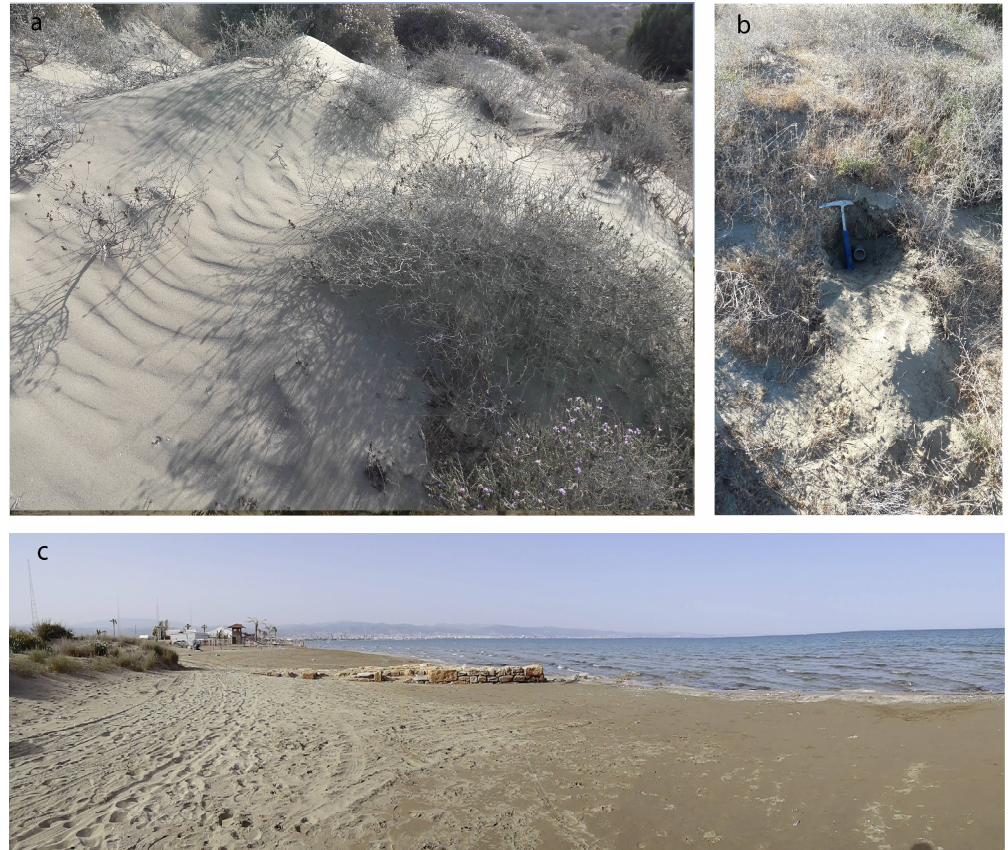
Figure 7. Eastern dune fields ( a ) coppice dunes ( b ) sampling of the coppice dunes ( c ) primary development next to the coastline, covering archeological